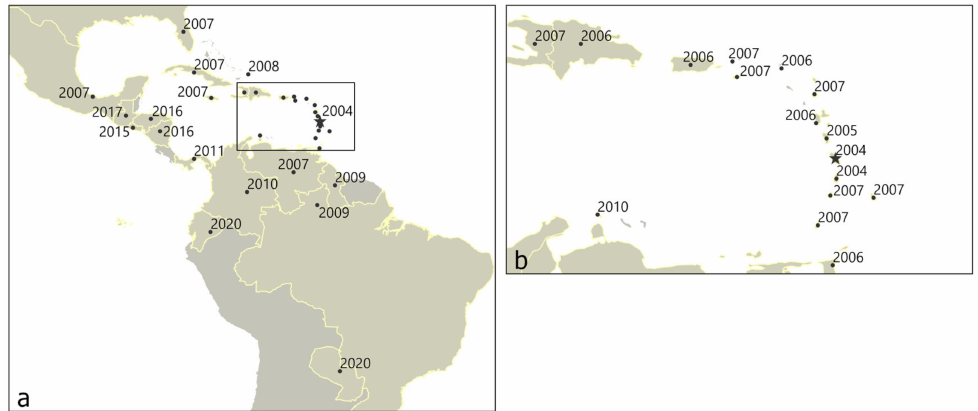
Figure 1. ( a ) Spread of the red palm mite (RPM, Raoiella indica Hirst) in the Western Hemisphere; ( b ) Island hopping in the Caribbean region. Locations indicate centroid of country, if no exact location of first observation is available. References in Table